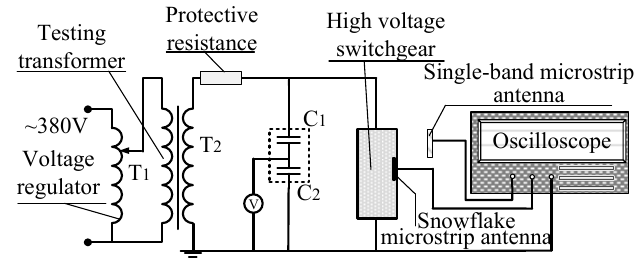
Figure 12. Experimental circuit diagram.